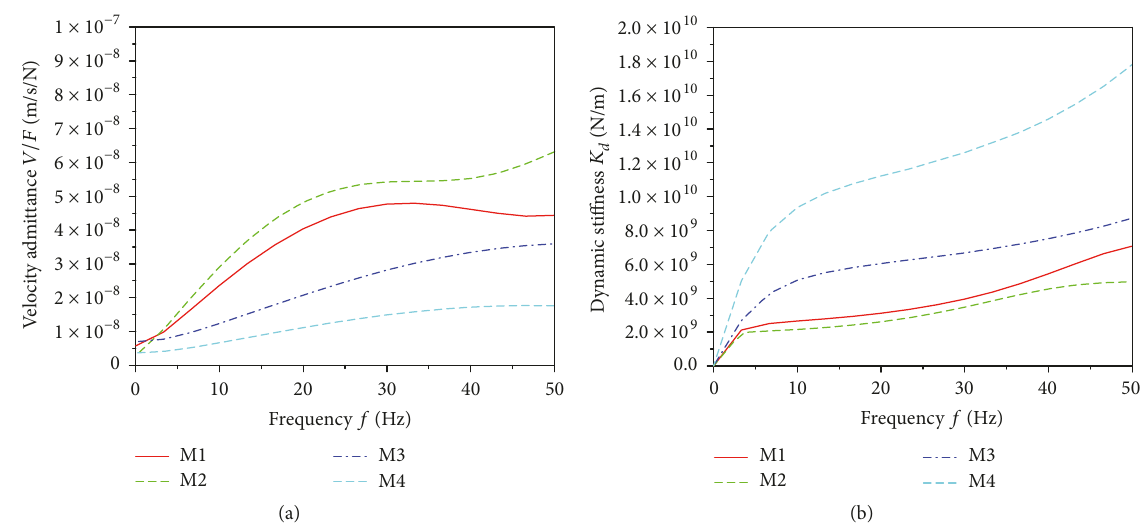
Figure 13: The (a) velocity admittance and (b) dynamics stiffness of four